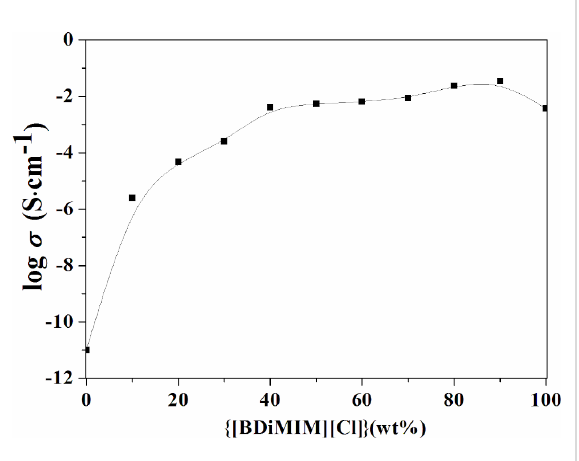
Figure 4: Variation of the electrical conductivity of a polymer gel elec- trolyte as a function of the polymer/ionic liquid blend concentration.